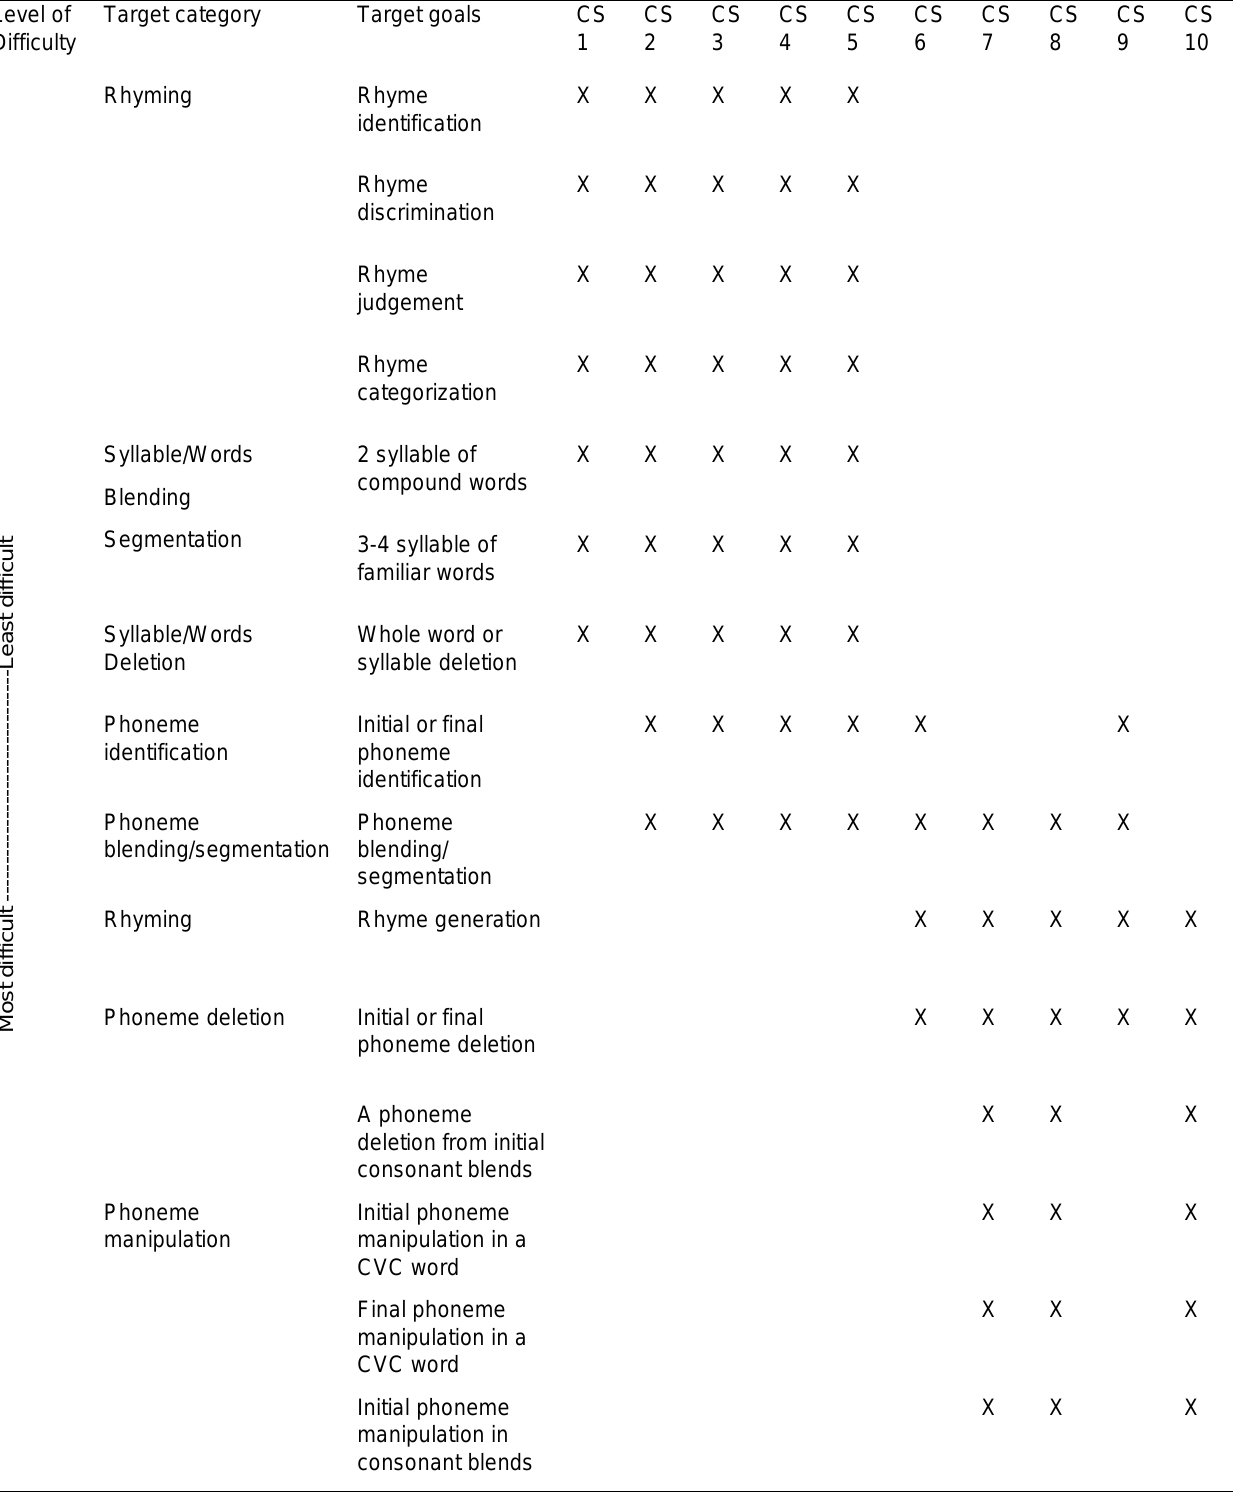
Table 4. Phonological Awareness Skills Targeted In-person Group Participants Level of Target Difficulty